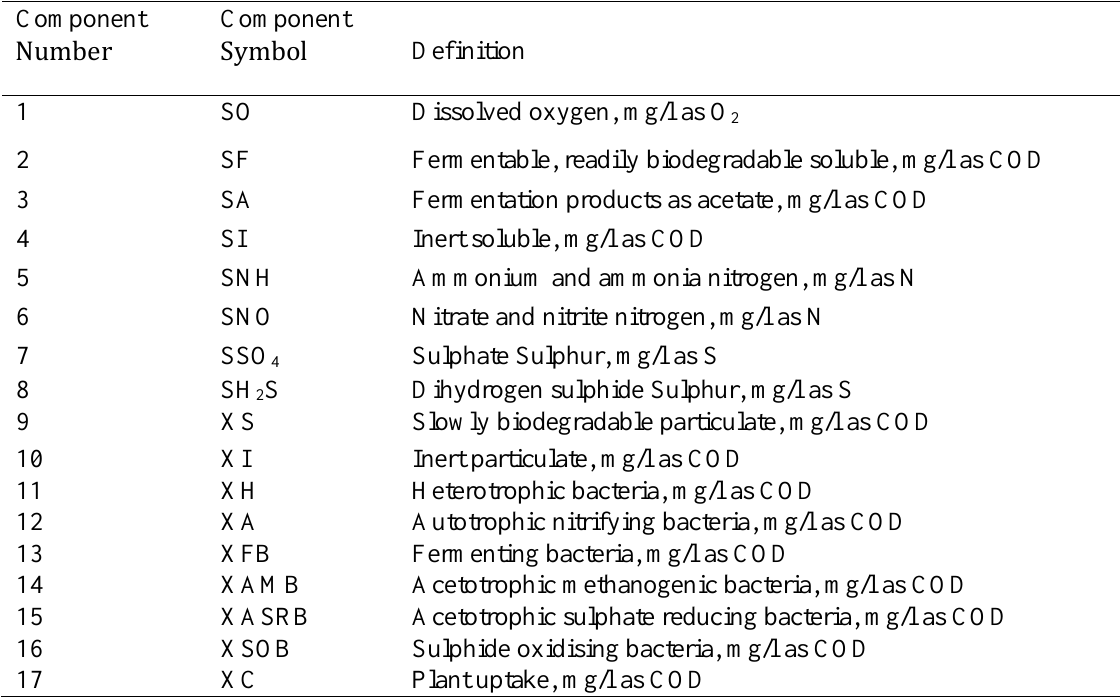
Table 2. Definitions of 1D-CWM1 model component ( Langergraber et al 2009, Rousseau, 2004).